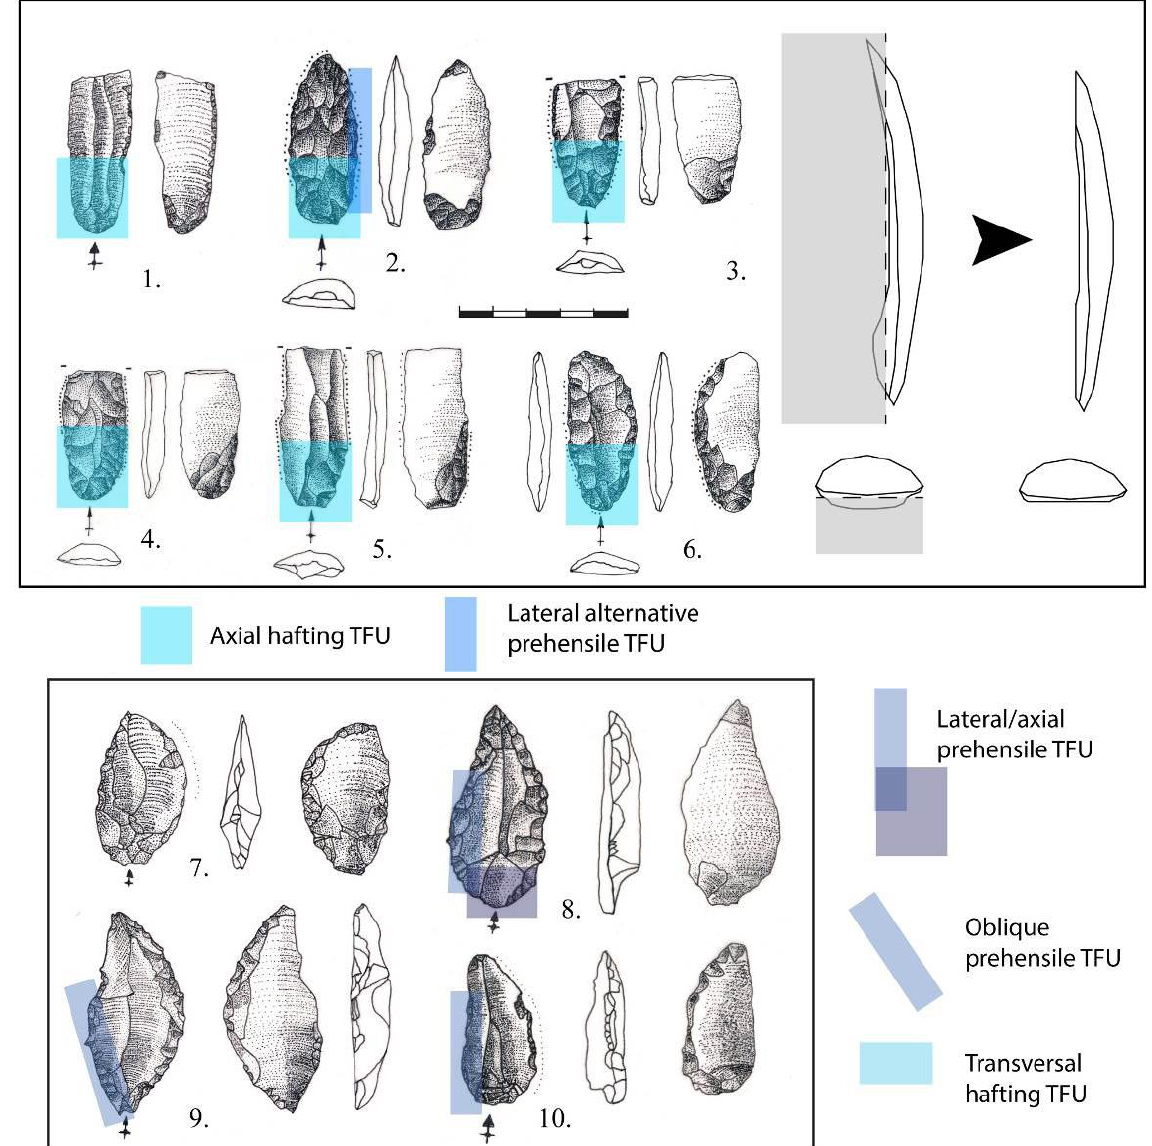
Figure 5. Different tool classes and their prehensile modes in Laguna Media